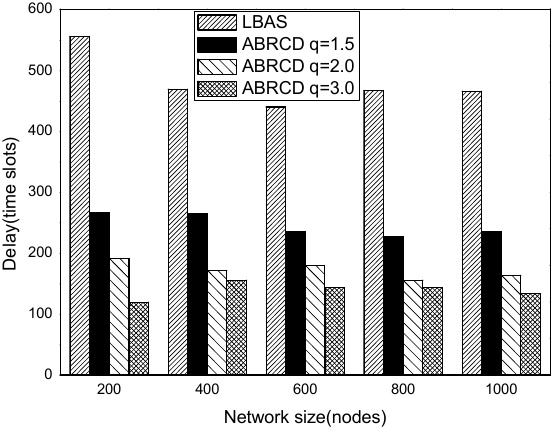
Figure 44. The impact of network size with fixed | T | = 40 on delay. Sensors 2018 , 18 , x FOR PEER REVIEW